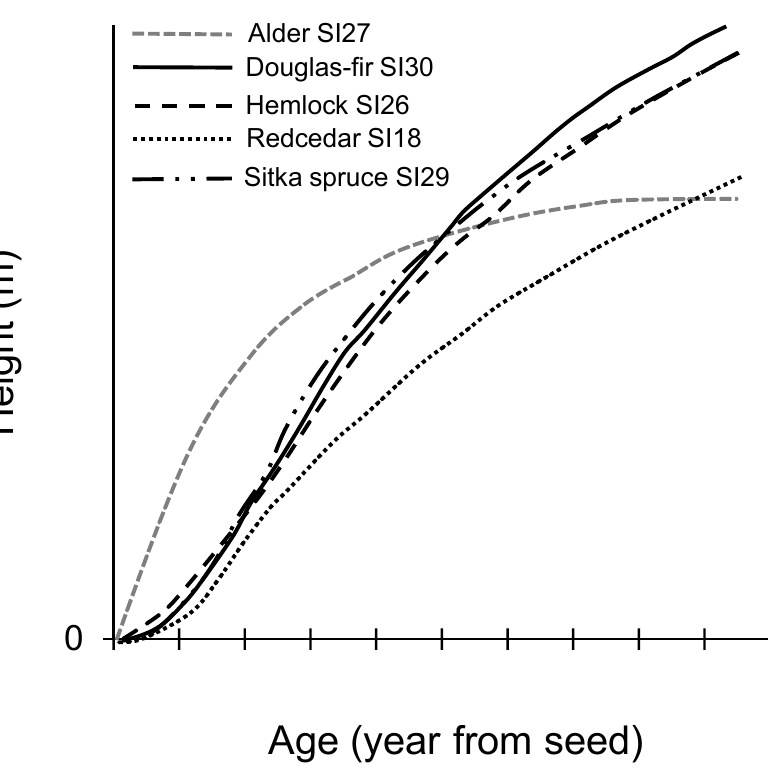
Figure 2. Comparison of height growth for red alder and associated conifers to age 100 years. Height growth is for stands of predominantly pure species (figure modified from Green and Klinka [73]).